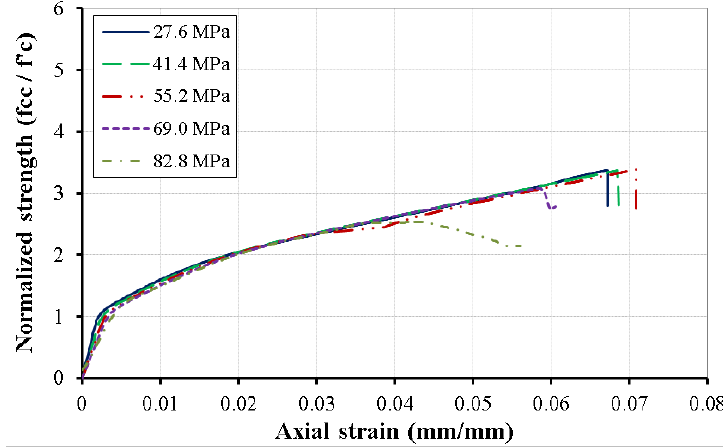
Figure 7. Axial strain-normalized strength relationship of CFFT with LRS-FRP with different concrete compressive strength ( 𝑓 𝑐′